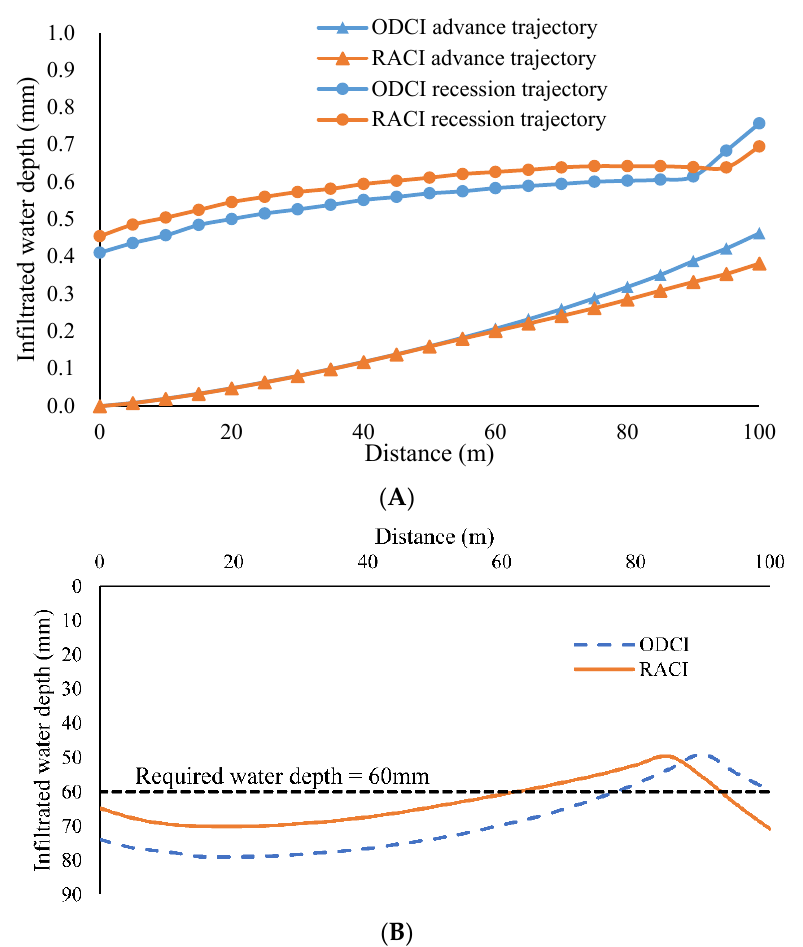
Figure 3. ( A ) Advance and recession trajectories and ( B ) infiltrated-water depths compared between ODCI and RACI for border S2.